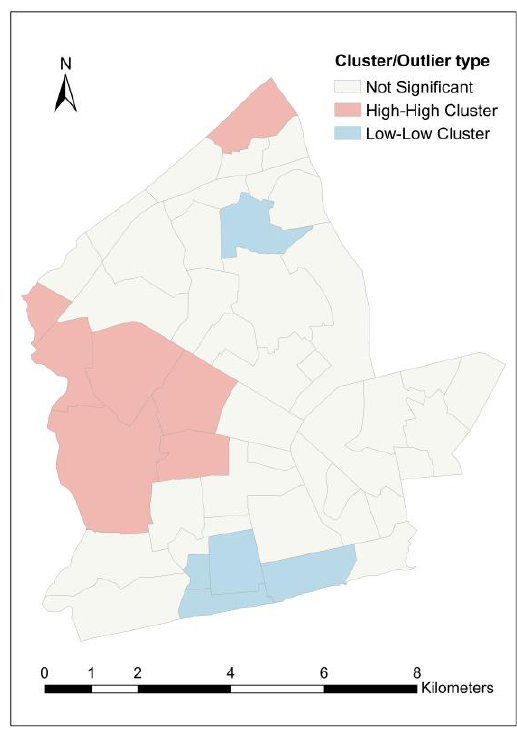
Figure 14. Cluster neighborhoods for load shedding exposure.